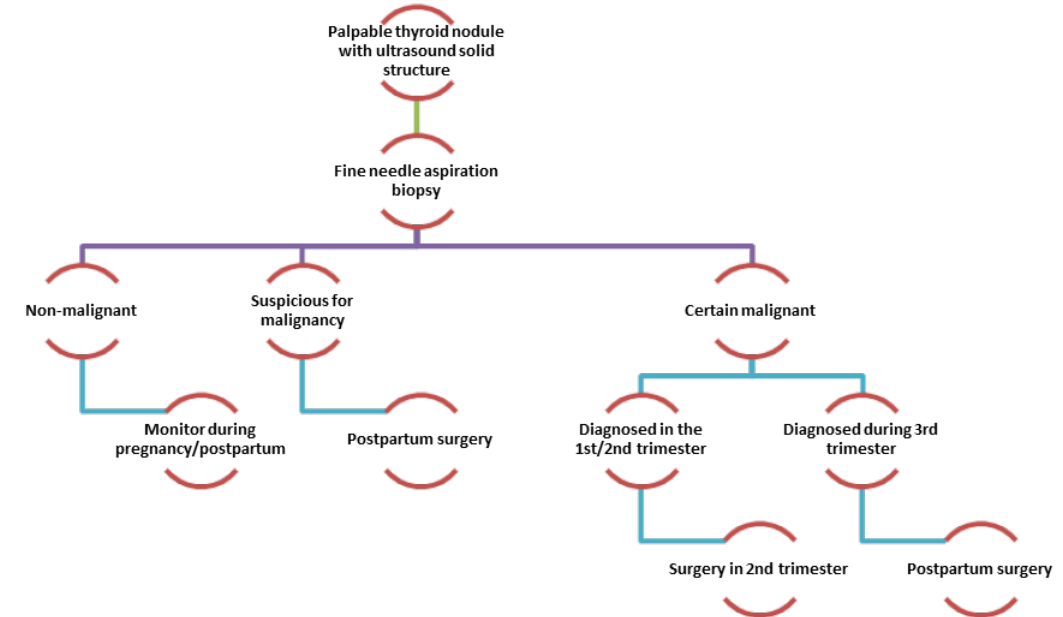
Figure 4. Management algorithm of palpable thyroid nodule during pregnancy.